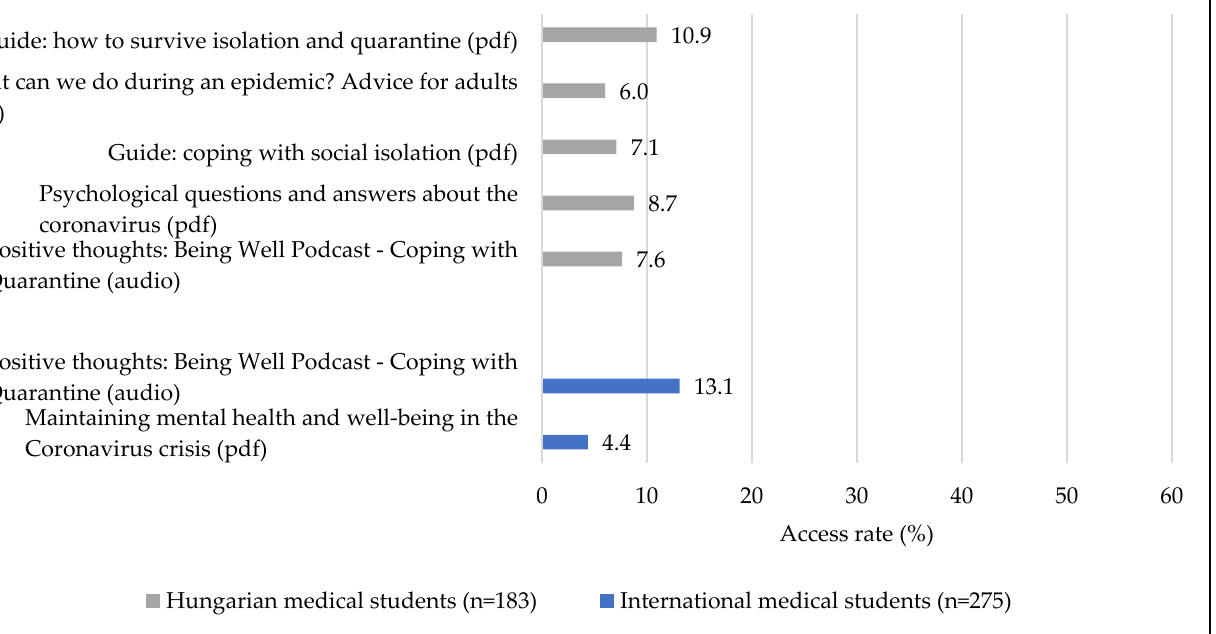
Figure 2. Access rate of materials helping to cope with mental health effects of COVID-19 separately by course type.